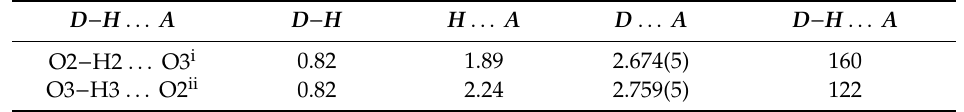
Table 2. Hydrogen-bonding geometry (Å , °) for 7